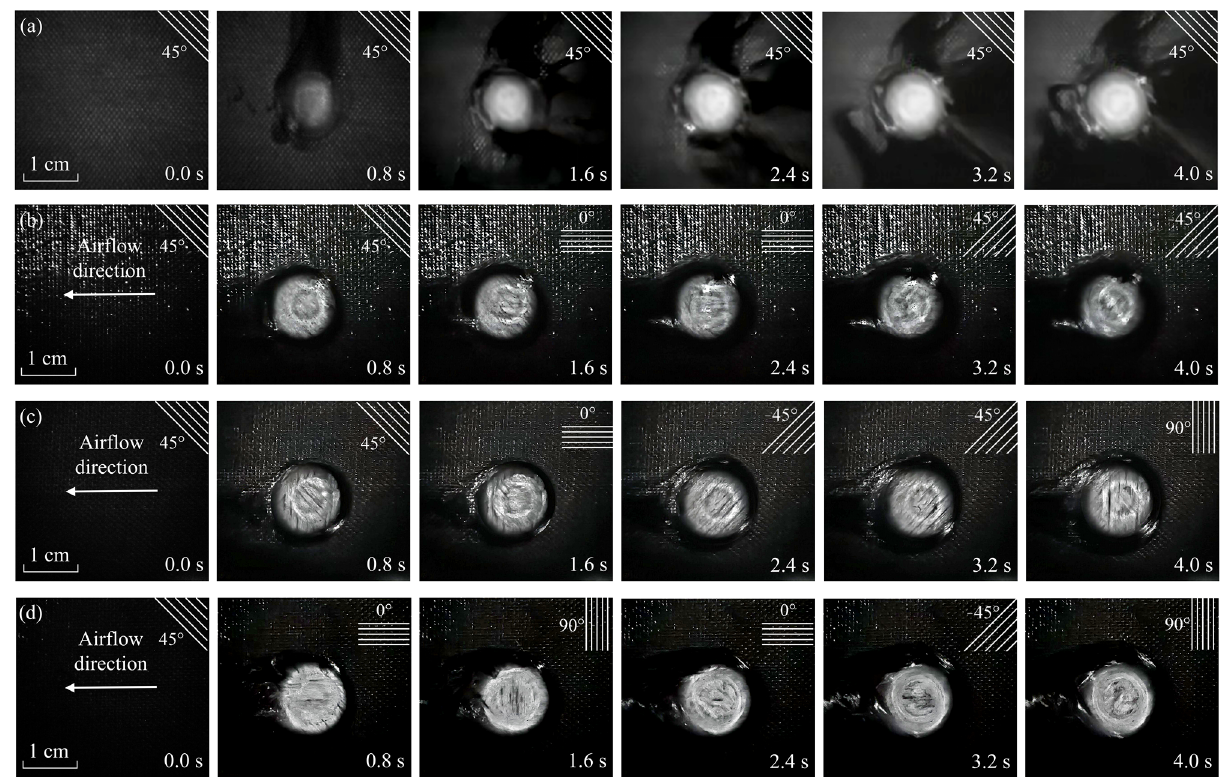
Figure 6. The laser irradiation process in different conditions. ( a ) Static air, 1273 W/cm 2 ; ( b ) Ma 1.8, 1273 W/cm 2 ; ( c ) Ma 3.0, 1273 W/cm 2 ; ( d ) Ma 3.0, 2546 W/cm 2 .